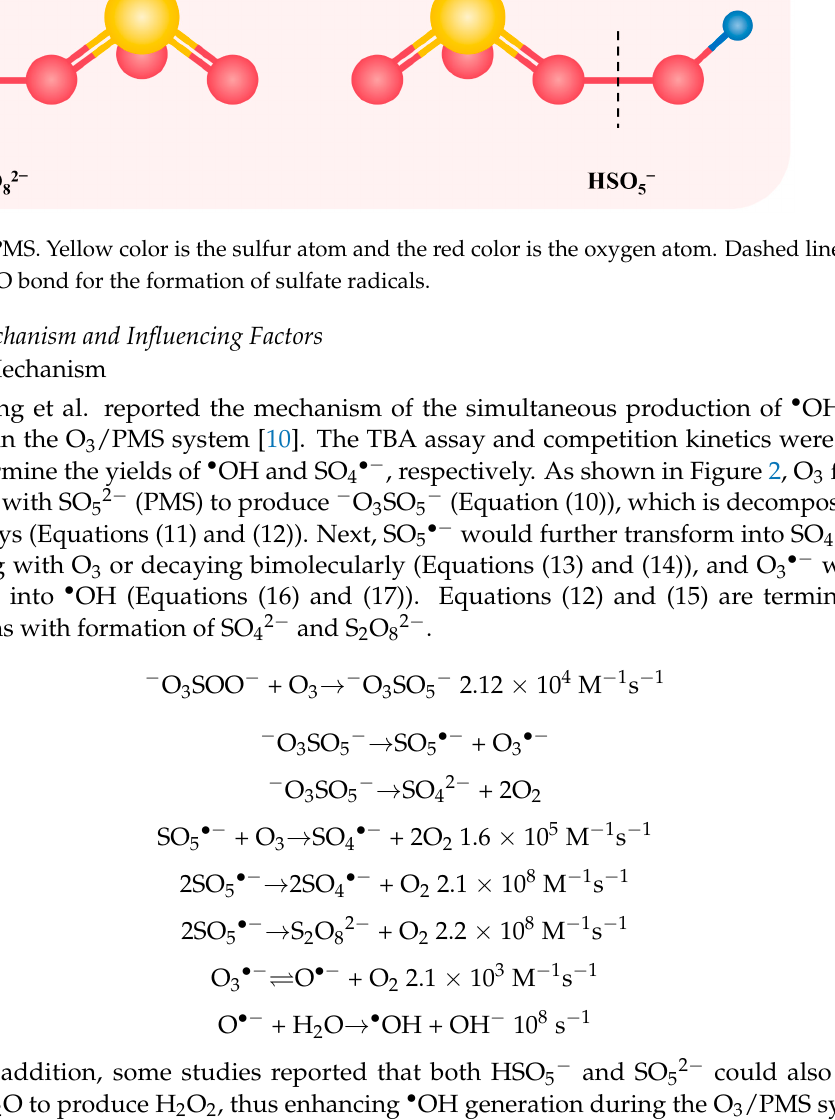
Figure 2. The mechanism of the simultaneous production of • OH and SO 4• − in the O 3 /PMS system.